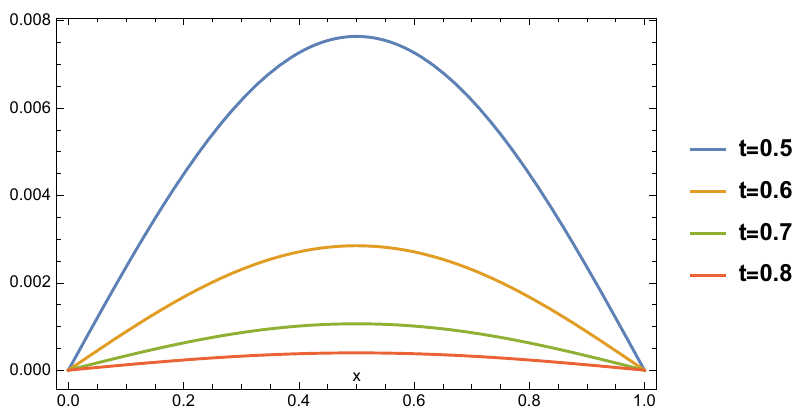
Figure 1. The approximate solutions of Example 1 at different times.